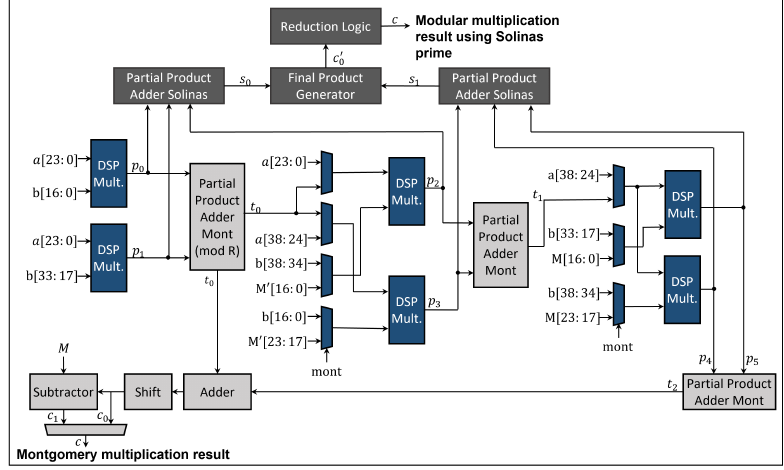
Figure 7: Architecture of dual multiplier supporting up to 24-bit Montgomery multiplica- tions and 39-bit modular multiplications using Solinas prime P = 2 39 − 2 12 +